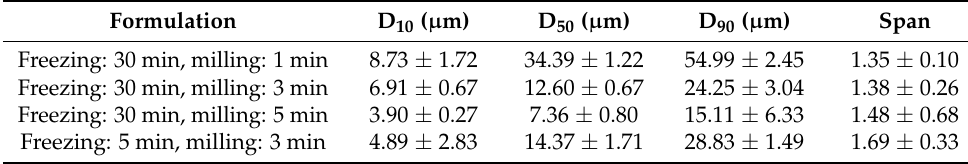
Table 1. Operating Conditions of Freeze Milling and Particle Size of the Milled Nanofiber Mats. Formulation D 10 ( µ m) D 50 ( µ